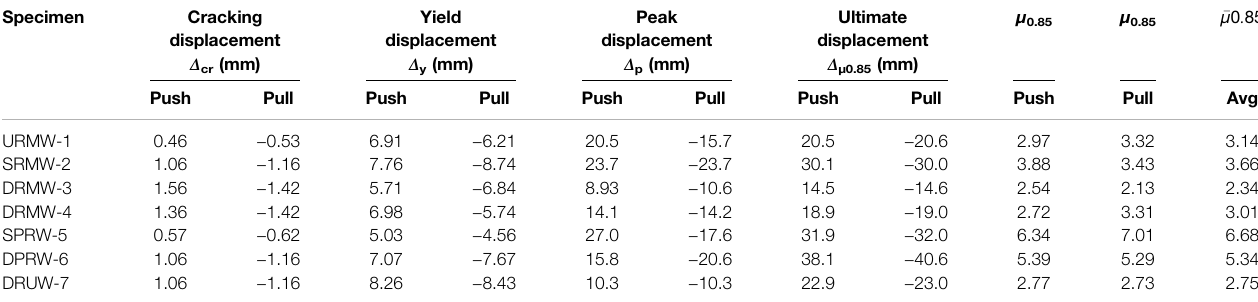
TABLE 5 | Critical displacements of the specimens. Specimen